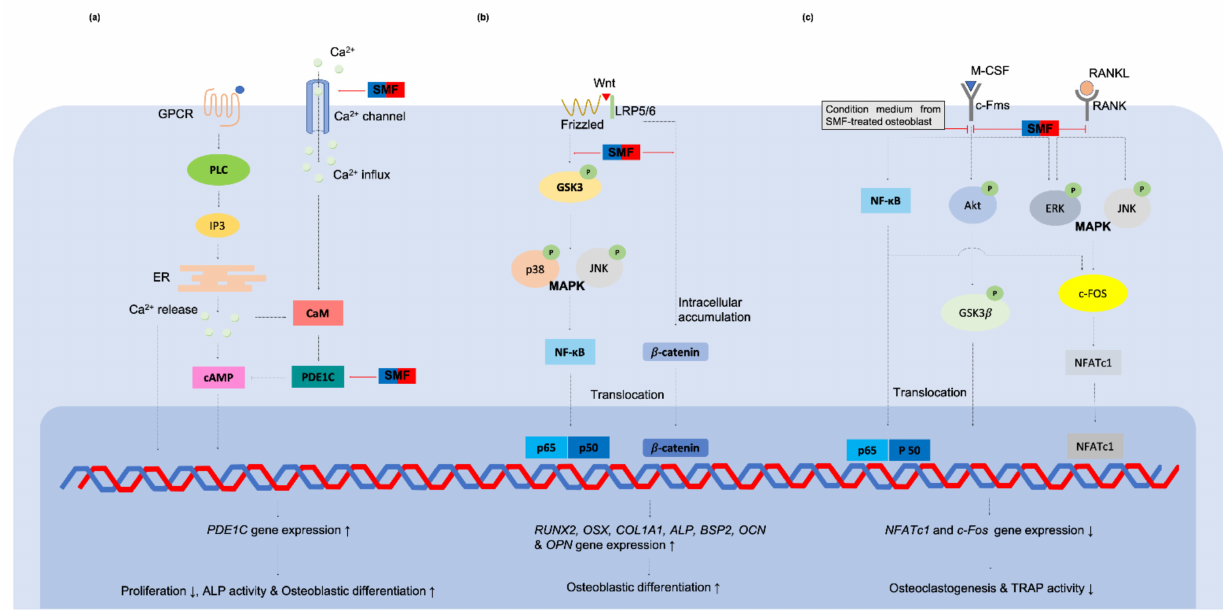
Figure 5. Relevant signaling cascades for bone-related cells when stimulated by SMFs. ( a ) The differentiation promoting effect of osteoblast-like MG-63 cell by 0.4 T SMF is correlated to a calcium-activated calmodulin signaling pathway [74]. Increasing of the intracellular calcium ions concentration activates CaM and PDE1C, which further suppresses cAMP activity and decreases cell growth. Calcium ions act as a second messenger that induces subsequent signaling cascades and finally oseoblastogenesis; ( b ) The Wnt/ β -catenin-p38 and JNK MAPKs-NF- κ B signaling pathways were activated under SMF to stimulate osteoblastic differentiation [60]; ( c ) Direct effects of SMF on osteoclastogenic inhibition in macrophages [62]. SMF and the condition medium from SMF-treated osteoblasts suppressed RANK/RANKL and c-Fms/M-CSF signaling transduction, thus reducing TRAP activity and osteoclastogenesis. Abbreviations: GPCR = G-protein-coupled receptor; PLC = Phospgolopase C; IP3 = Inositol trisphosphate; ER = endoplasmic reticulum; cAMP = Cyclic adenosine monophos- phate; CAM = Calmodulin; PDE1C = Phosphodiesterase 1C; LRP5/6 = low-density lipoprotein receptor-related protein 5 and 6; GSK3 = Glycogen synthase kinase 3; MAPK = Mitogen-activated protein kinase; NF- κ B = nuclear factor kappa- light-chain-enhancer of activated B cells; Runt-related transcription factor 2; OSX = Osterix; COL1A1 = Collagen type I alpha 1 chain; ALP = Alkaline phosphatase; BSP2 = Bone sialoprotein 2; OCN = Osteocalcin; OPN = Osteopontin; M- CSF = Macrophage colony-stimulating factor; c-Fms = Colony-stimulating factor-1 receptor; RANK = Receptor activator of nuclear factor kappa-light-chain-enhancer of activated B cells; RANKL = RANK ligand; Akt = a serine/threonine protein kinase; GSK3 β = Glycogen synthase kinase 3 beta; NFATc1 = Nuclear factor of activated T cells 1; TRAP = Tartrate-resistant acid